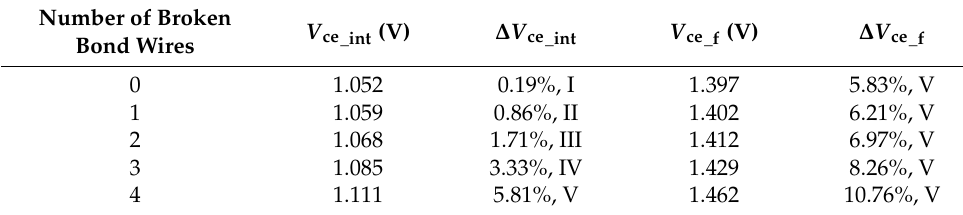
Table 4. Aging monitoring results in the case of T j = 75 ◦ C.